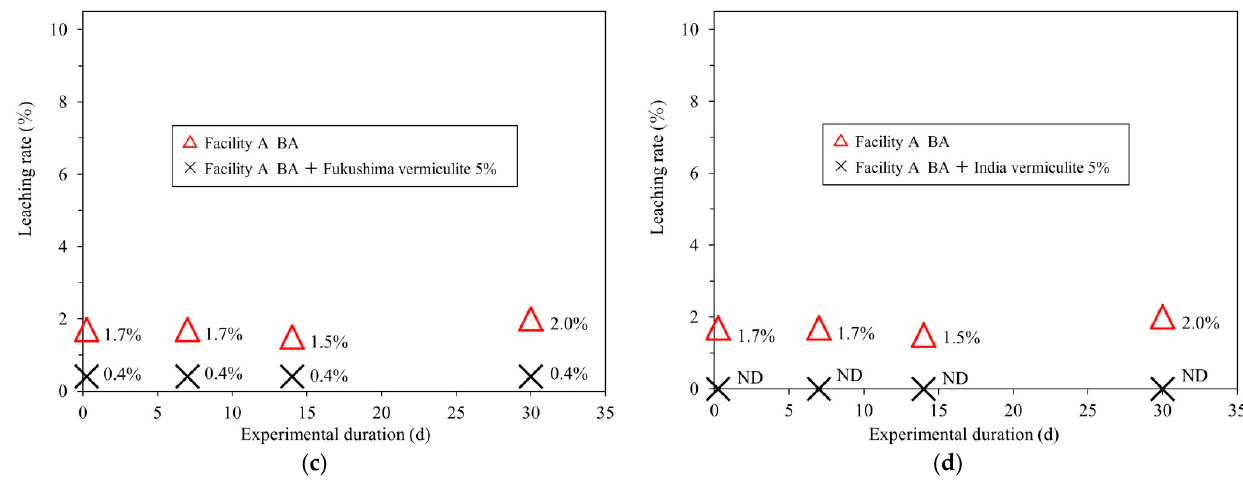
Figure 5. Changes in radioactive cesium leaching rate with respect to time (bottom ash, BA): ( a ) Zeolite; ( b ) Acid clay; ( c ) Fukushima vermiculite; ( d ) India vermiculite.